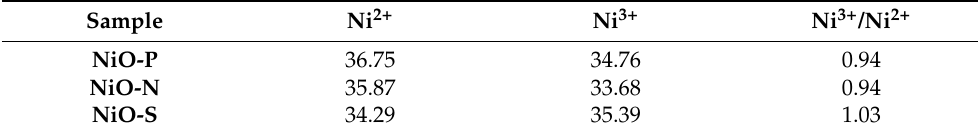
Table 3. The ratio of Ni 2+ and Ni 3+ of NiO-P, NiO-N, and NiO-S.